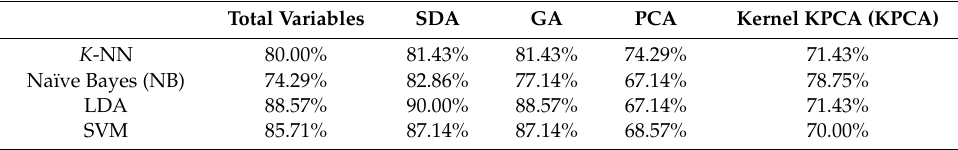
Table 4. Cultivar classification performance based on embryo-side features of sweet corn